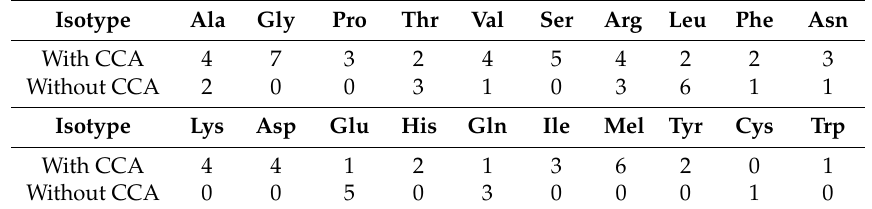
Table 1. Distribution of tRNA isotypes with and without an encoded 3 (cid:48) CCA in B. subtilis .